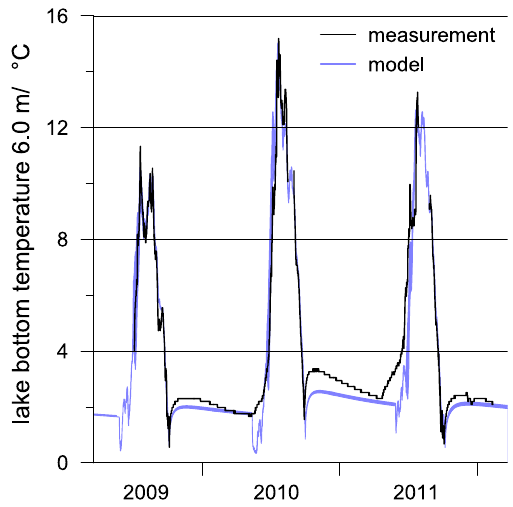
Figure 6. Modeled and measured temperature at the bottom of a 6m deep thermokarst lake on Samoylov Island for the years 2009 to 2012. The measurements are described in detail in Boike et al. (2015), the model results are derived from validation runs for a lake stratigraphy with snow densities of 200kgm − 3 and of 250kgm − 3 (see Sect.